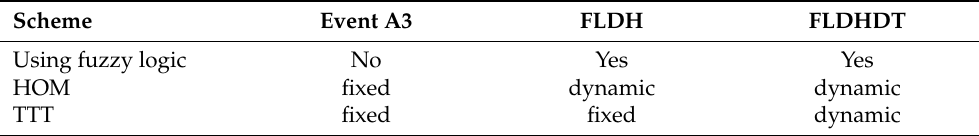
Table 6. Differences among event A3, FLDH, and FLDHDT.